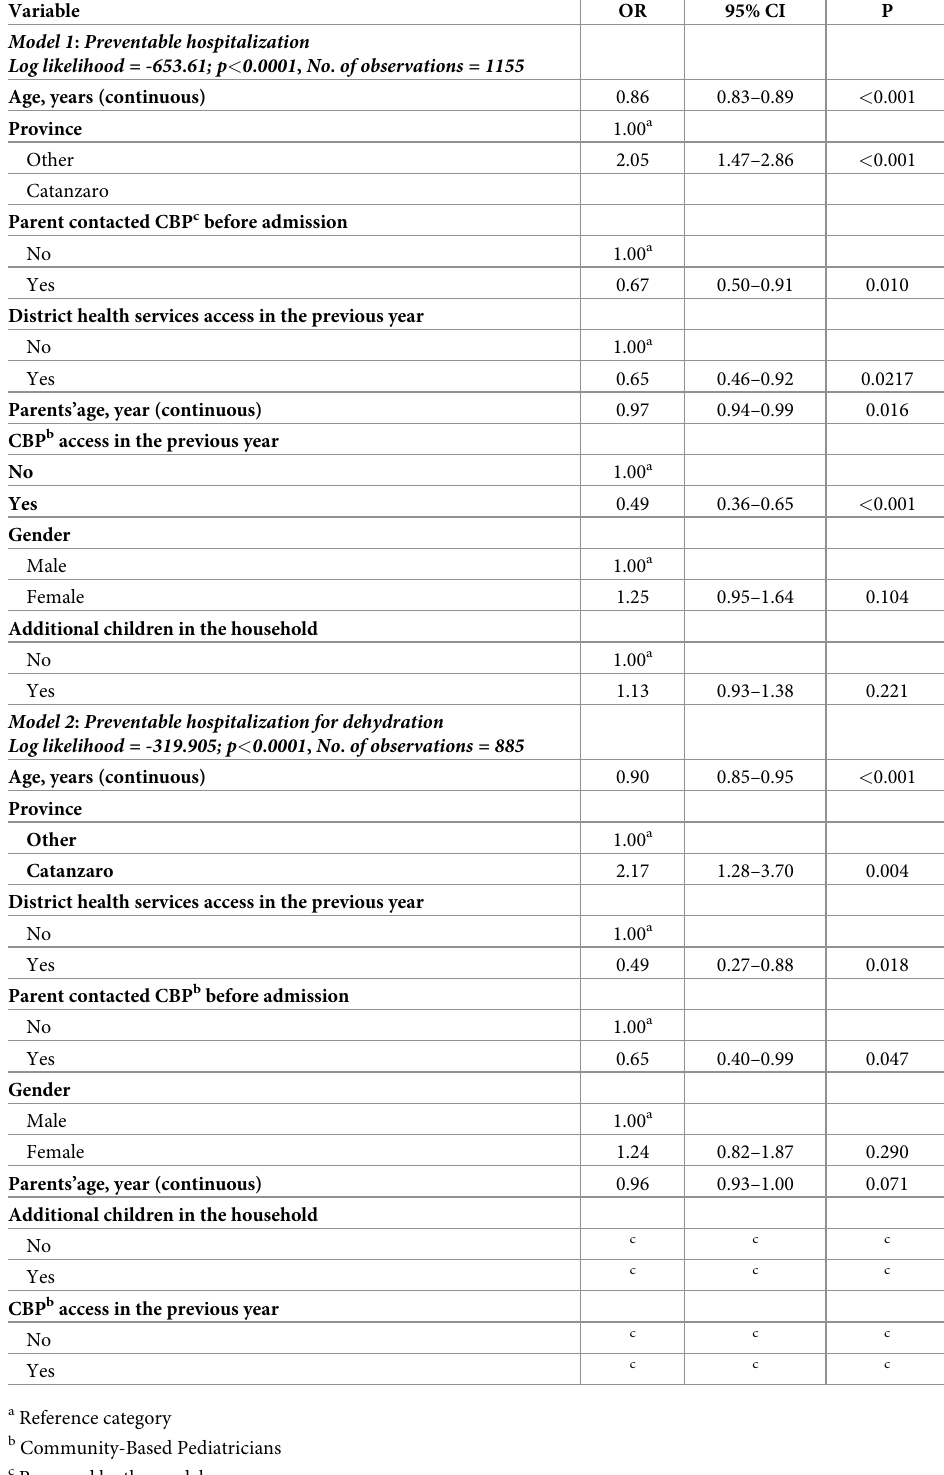
Table 3. Multiple logistic regression analysis